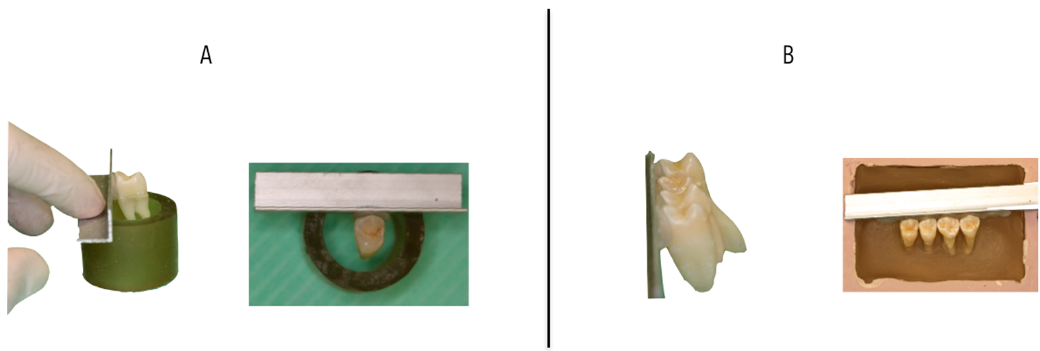
Figure 1. Representative images of mounting jigs. ( A ) Direct bonding samples, ( B ) Indirect bonding samples. Table 1. Composition of tested adhesive systems.